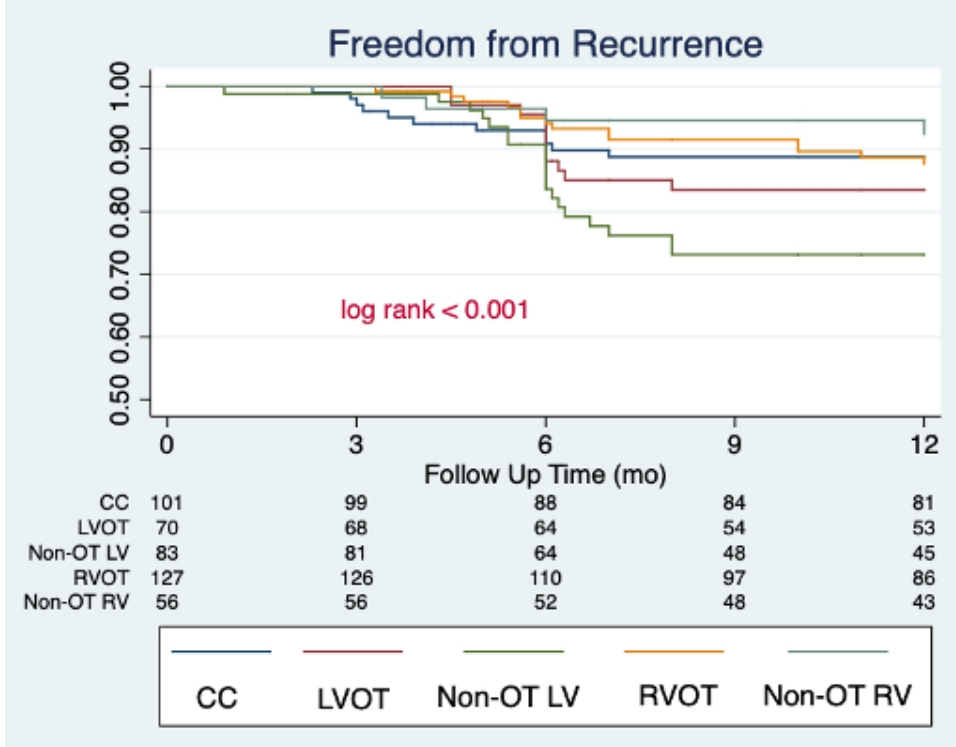
Figure 1. Changes in 24 h% burden over time stratified by PVC localization. Abbreviations: CC: coronary cusps, LV: left ventricle, LVOT: left ventricular outflow tract, OT: outflow tract, RV: right ventricle, RVOT: right ventricular outflow tract.